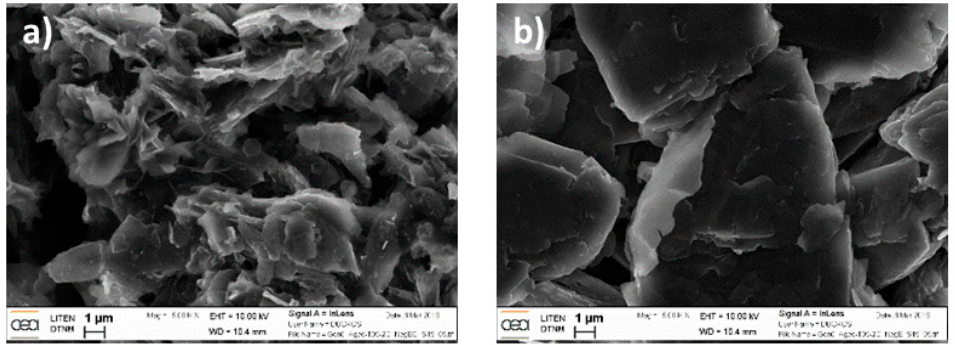
Figure 5. SEM images of the graphite anode of Cell B sampled at the ( a ) center and ( b ) edge of the tape. Both samples were taken from the middle (M) of the stack.